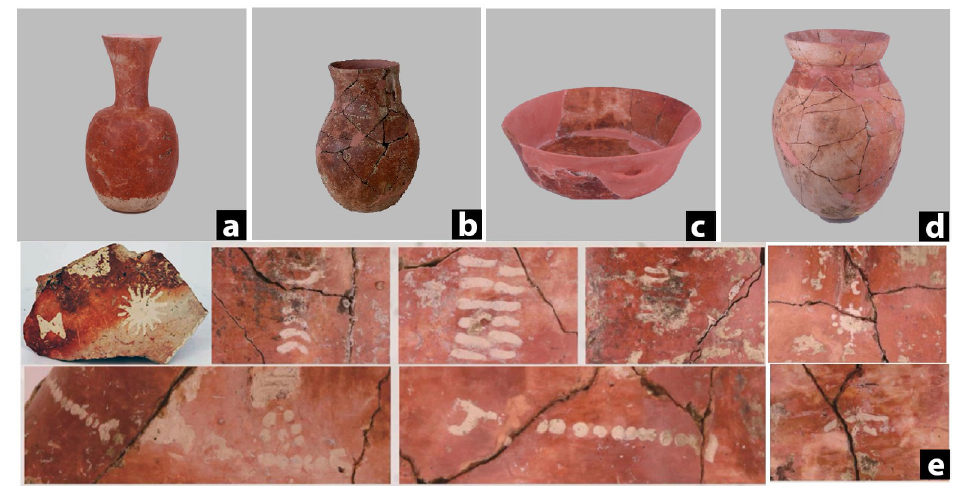
Fig 3. Representative pottery types recovered from Qiaotou. (a) and (b) Long-necked hu vessel; (c) Bowl; (d) Jar; (e) A selection of painted patterns from Qiaotou pottery.